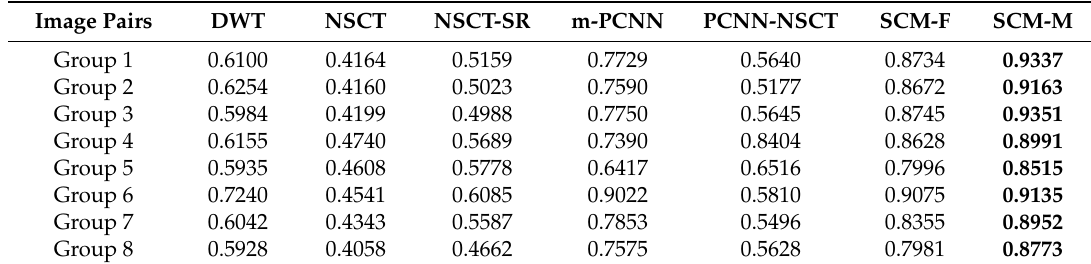
Table 5. Q T for the seven methods operating on the eight groups of medical images.